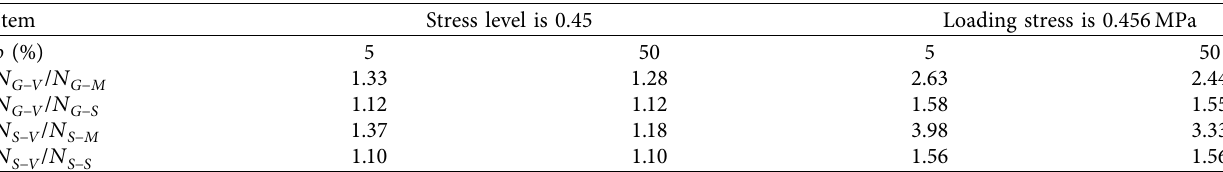
Table 13: Comparison of fatigue life of the SMA-13 mixture under different compaction methods. Item